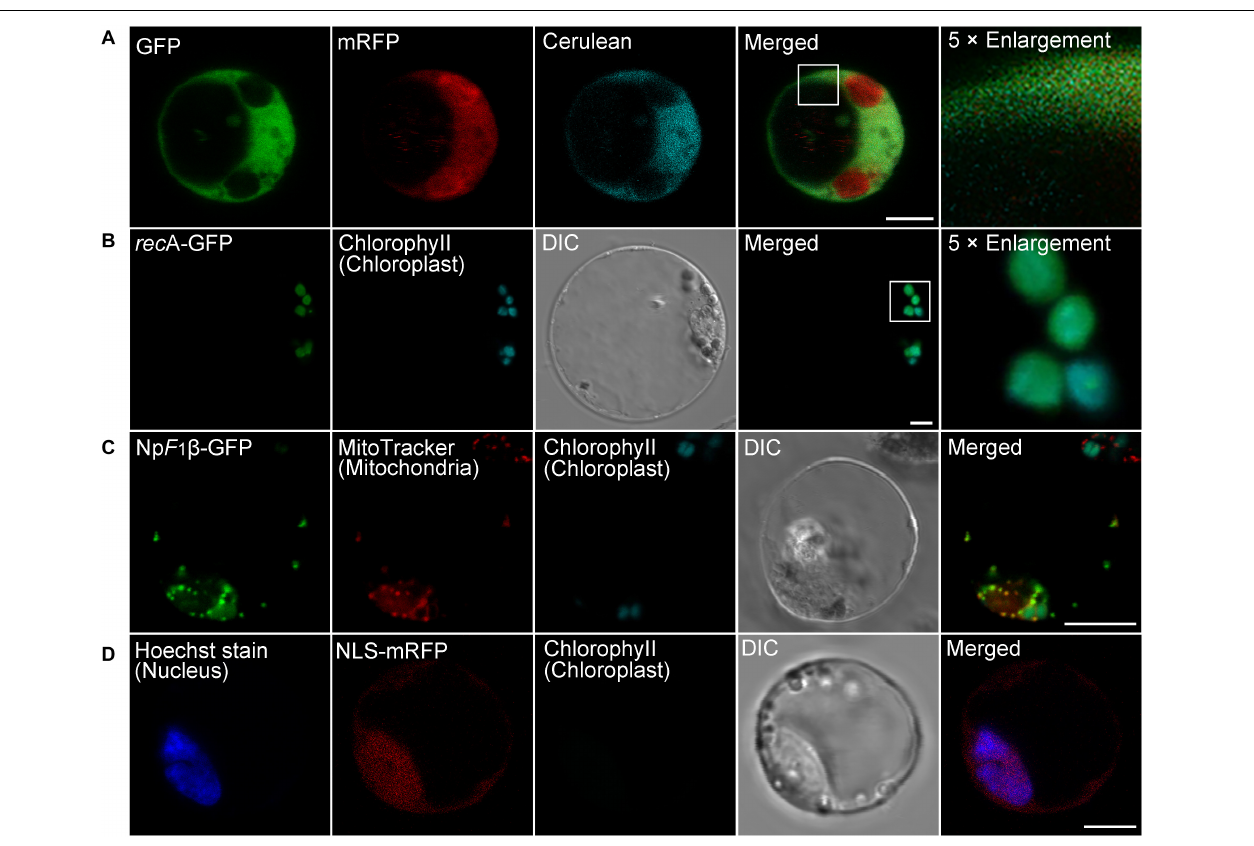
FIGURE 3 | Subcellular localization of various organelle markers in moso bamboo protoplasts. (A) Fluorescent patterns of GFP (green), monomeric red fluorescent protein (mRFP) (red), and cerulean (cyan) in cotransformed protoplasts. (B) The chloroplast stroma marker rec A-GFP was transformed into protoplasts. The GFP signal (green) completely colocalized with chlorophyll autofluorescence (cyan). (C) The mitochondria matrix marker Np F 1 β –GFP was transformed into protoplasts, and transformed protoplasts were subsequently stained with MitoTracker for 5 min. The GFP signal (green) completely colocalized with the mitochondria signal (red). (D) The nucleus marker NLS–mRFP was transformed into protoplasts, and transformed protoplasts were subsequently stained with nuclear Hoechst for 5 min. The mRFP signal (red) colocalized with the nuclear Hoechst signal (blue). DIC, differential interference contrast. Scale bar = 5 µ